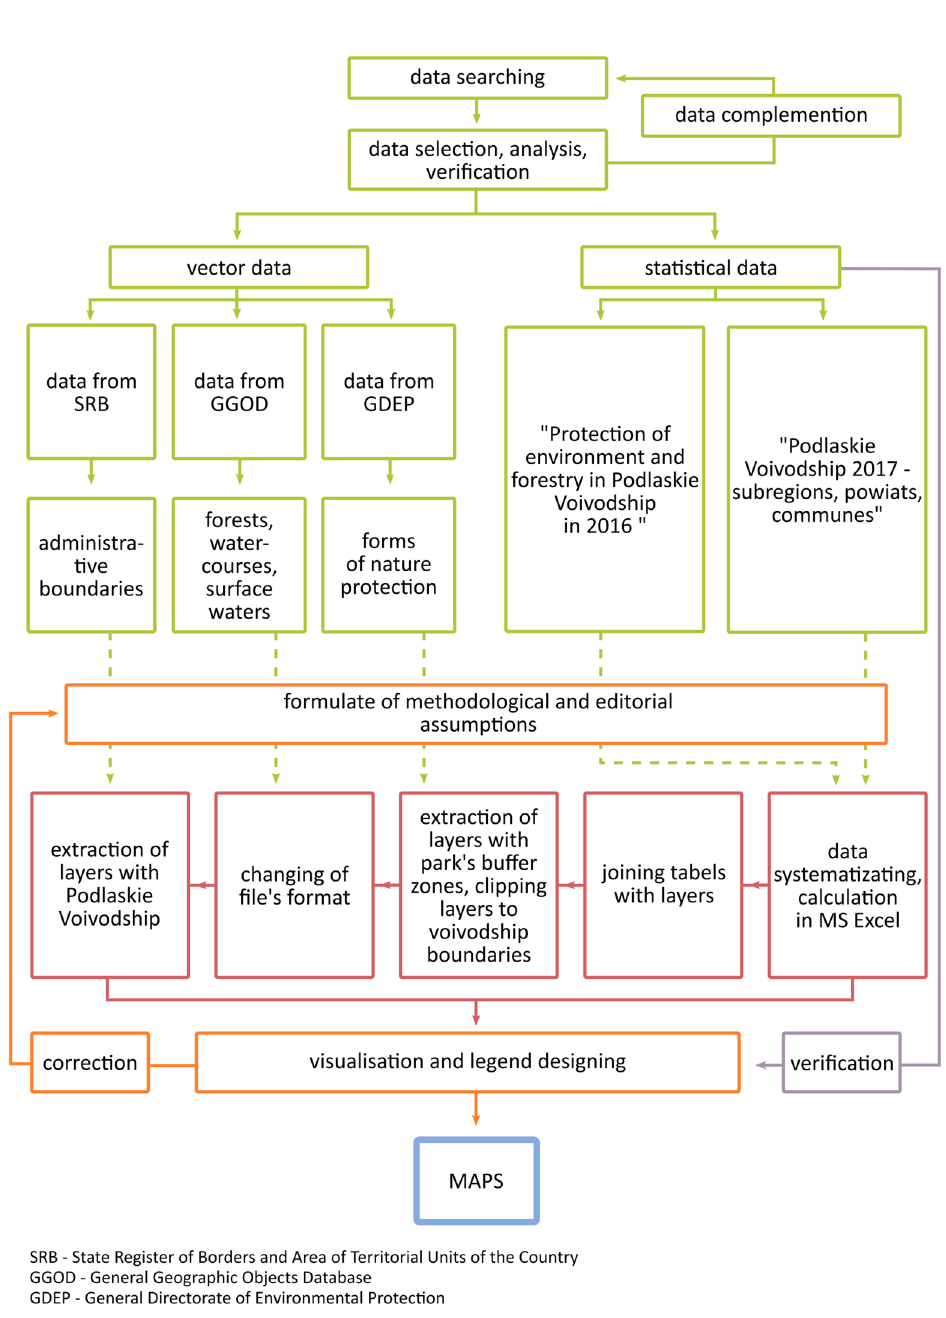
Fig. 2. The methodological scheme of map elaboration